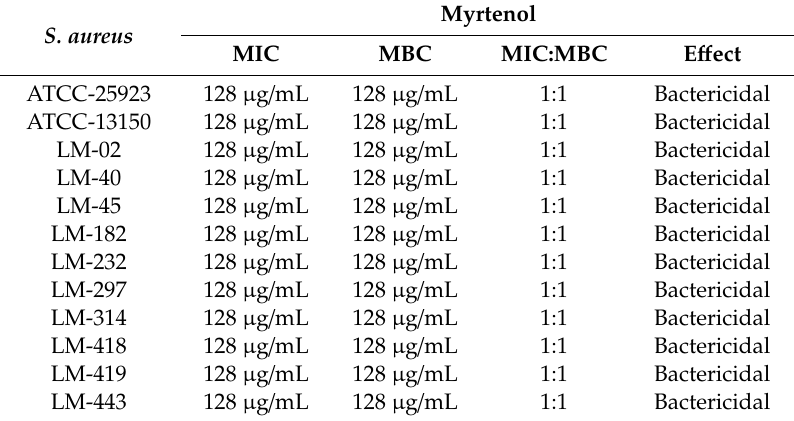
Table 1. Minimal Inhibitory Concentration (MIC), Minimal Bactericidal Concentration (MBC) and classification of the e ff ect of myrtenol against S. aureus